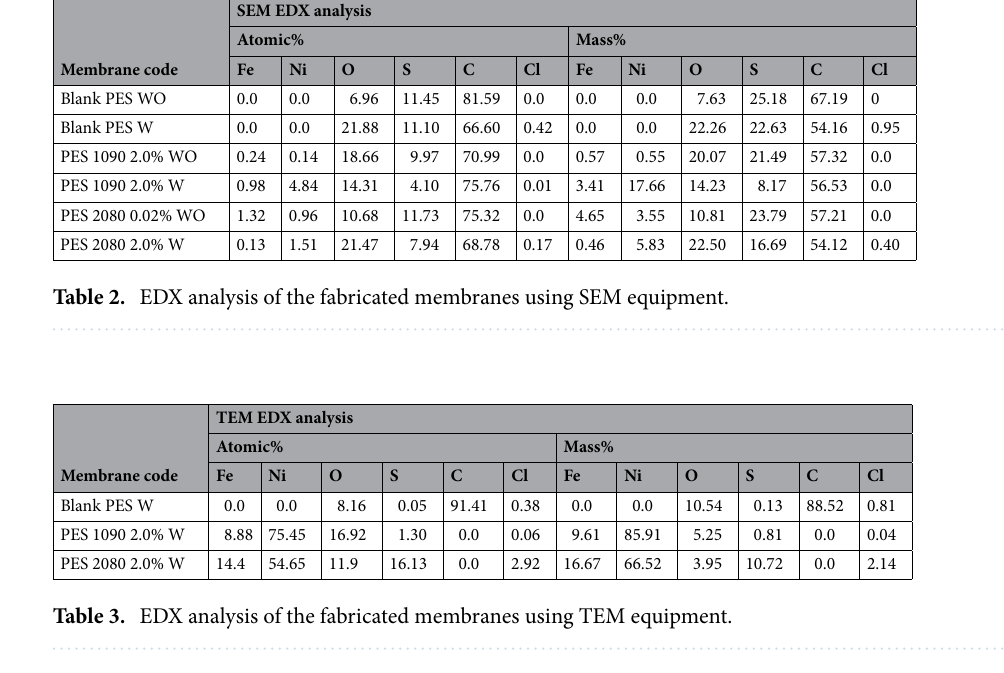
Fig. 12 supports the uniform distribution of the used iron–nickel alloy inside the magnetic matrix PES mem- brane. Mechanical strength. As shown in Fig. 13, the ultimate tensile strength of the blank PES membrane has slightly decreased with using the Lithium chloride in the membrane dope, however, the addition of magnetic iron–nickel alloys with different microstructures has differently affected the mechanical strength of the fab- ricated magnetic mixed matrix PES membranes. The starfish-like; Fe 10 Ni 90 , affects positively the membrane strength whereas the necklace-like; Fi 20 Ni 80 , affects it negatively. This can be attributed to the good hanging of the cones of the starfish-like iron–nickel alloy with the polymeric matrix rather than the crowded necklace-like iron–nickel alloy as indicated by TEM and SEM imaging. Vibrating sample magnetometer (VSM) analysis. The M-H hysteresis loops of the blank PES and the magnetic mixed matrix PES membranes are shown in Fig. 14. The magnetic mixed matrix PES membranes form an S-shape to show their magnetic properties, but the blank PES membranes do not form a clear S-shape. The effect of Lithium chloride on the membrane magnetic properties is unique and not completely understood 43 . The coercivity (Hc) and the magnetization (Ms) of the used alloys (Fe 10 Ni 90 and Fe 20 Ni 80 ), the bank PES, and the magnetic mixed matrix PES membranes without and with using Lithium chloride in the membranes dopes are shown in Fig. 15. The results of the magnetic vibration of the fabricated magnetic mixed matrix PES mem- branes showed high coercivity (Hc; Oe) than the blank PES membrane (about 147% improvement) in case of the absence of Lithium chloride additive. The blank PES in the case of using Lithium chloride in the membrane dope showed an improvement in the coercivity of the membrane by a ratio of 83% which can be an indication of the non-complete removal of the Lithium chloride additive during the demixing process (membrane solidification process). The presence of some Lithium chloride in the membrane was also confirmed by EDX analysis. For that, in the case of using Lithium chloride as an additive, the improvement in the coercivity of the magnetic mixed matrix PES membrane was only 30% of the blank PES membrane. On the other hand, the magnetization of the magnetic mixed matrix PES membrane in the case of using Lithium chloride additive is almost three times the magnetization of the same magnetic mixed matrix PES membrane without using Lithium chloride additive in the membrane dope. The blank PES membrane without and with using Lithium chloride additive in the membrane dope showed almost no magnetization properties. According to the different iron–nickel alloys, the magnetic mixed matrix PES membranes that contained Fe 20 Ni 80 showed higher magnetization and lower coercivity than the magnetic mixed matrix PES membranes contained Fe 10 Ni 90 alloy. Regarding the required application, the gas separation without applying an external magnetic field on the separation cell highlights the coercivity property for better performance of the fabricated magnetic mixed matrix PES membranes.